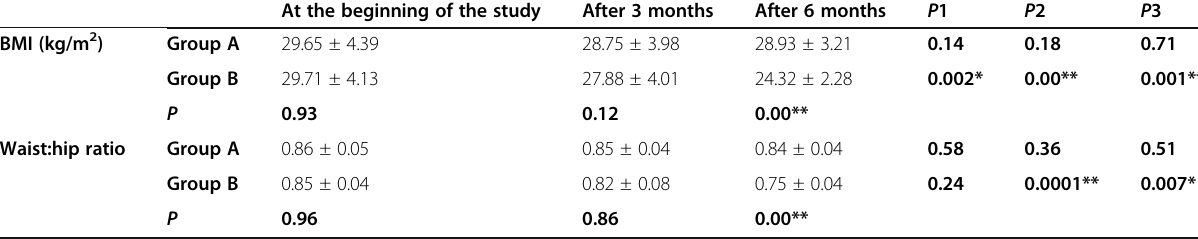
Table 3 Comparison of the body mass index and waist:hip ratio between the two studied groups At the beginning of the study